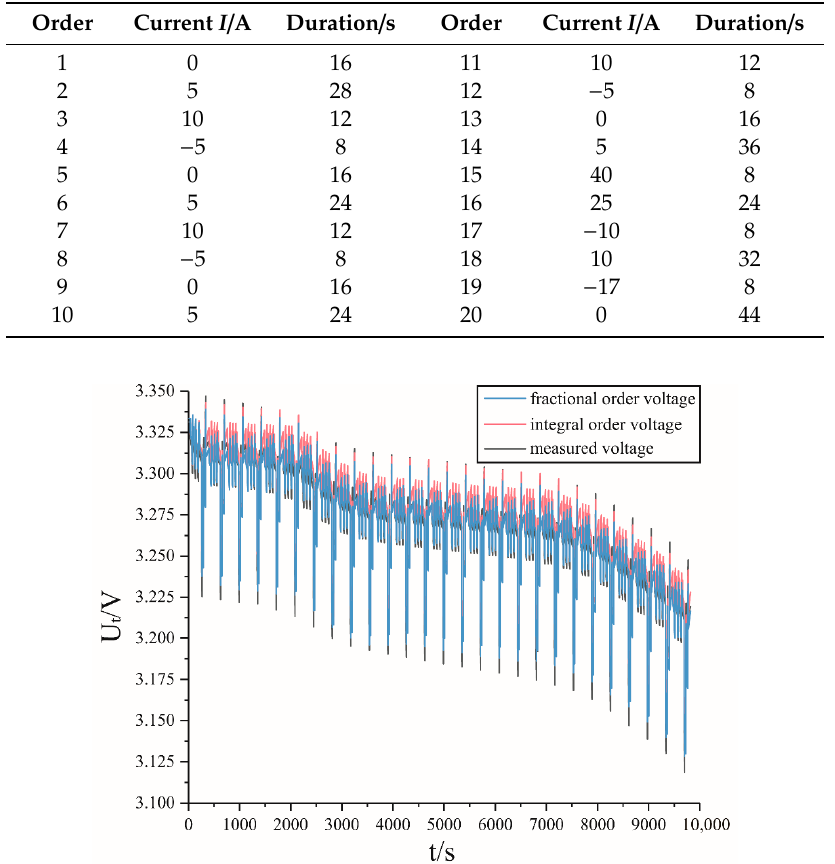
Figure 15. Comparison of terminal voltage between fractional model and integral model under 26 continuous DST conditions at 28 ◦